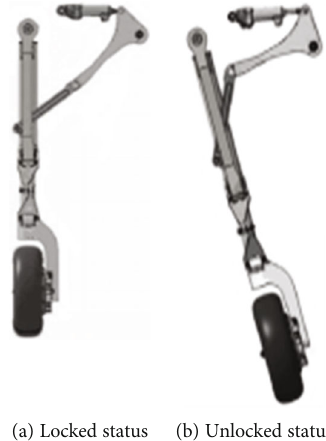
Figure 1: Working status of locking mechanism.